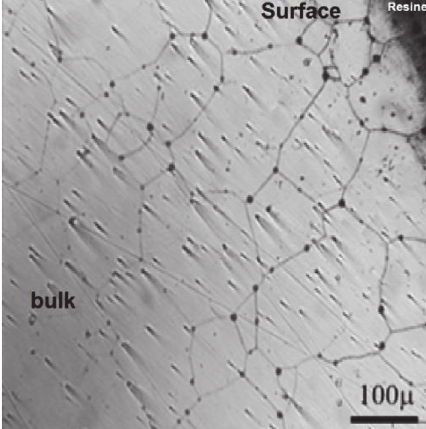
Figure 5: Optical microscopy image of reheater microstructure. Table 3: Ca, K, and Na content in fuel of the power